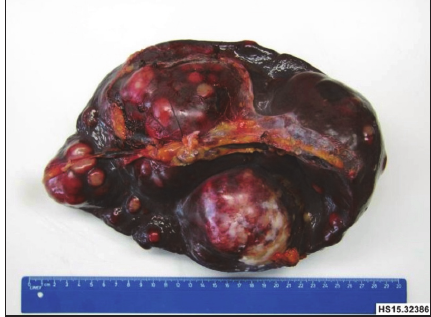
Figure 2: Macroscopically a multinodular infiltration of the spleen was seen.